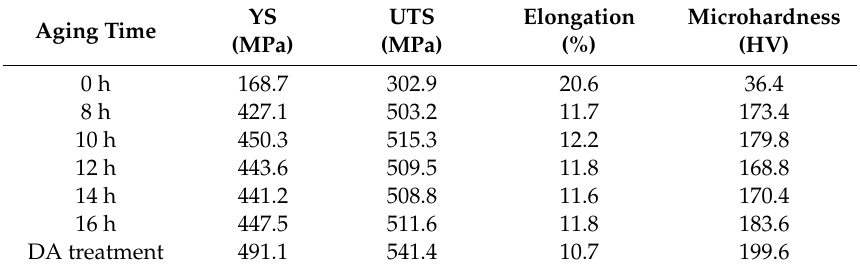
511.6 491.1 541.4